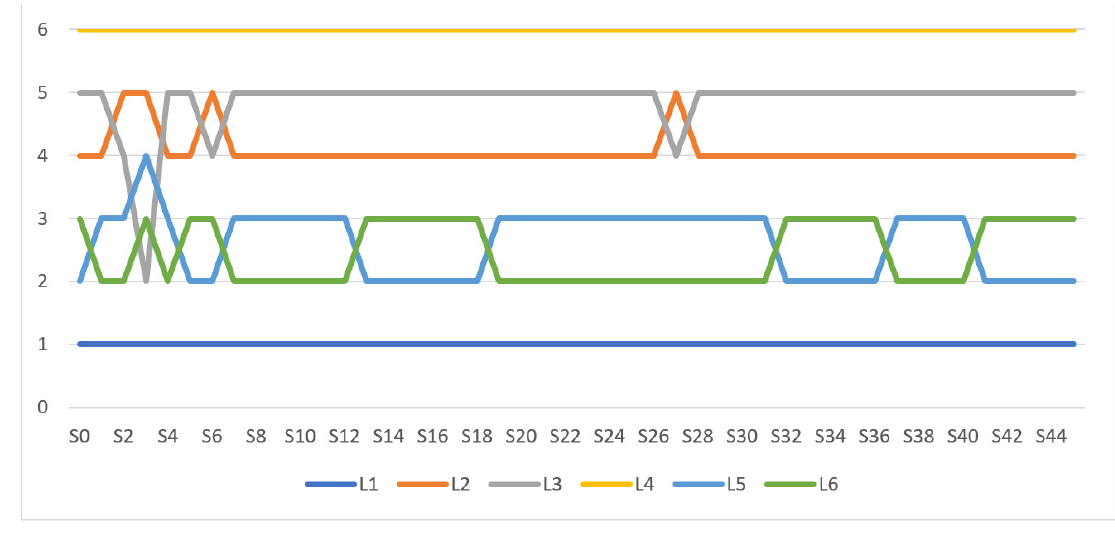
Figure 2 Sensitivity